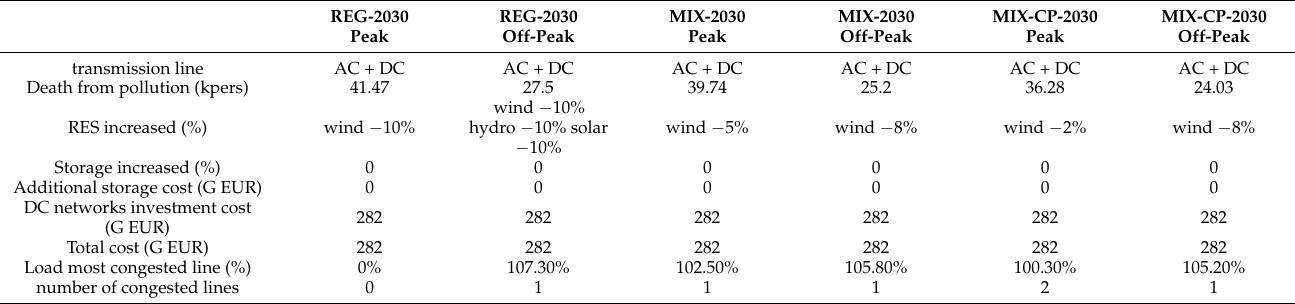
Table 3. Comparison of Integrated HVAC-HVDC grid.